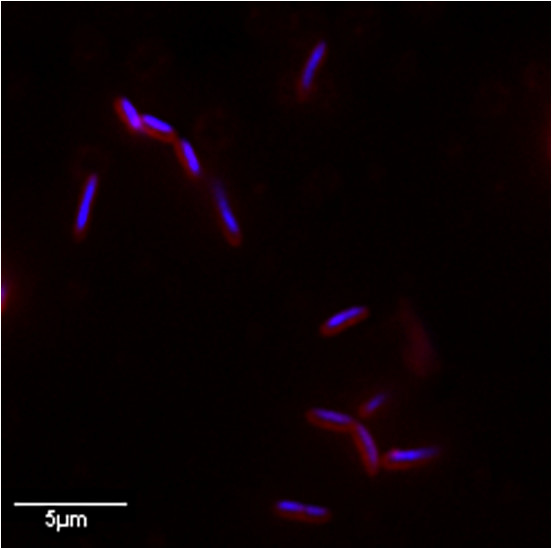
An epifluorescence image of Thermus aquaticus.